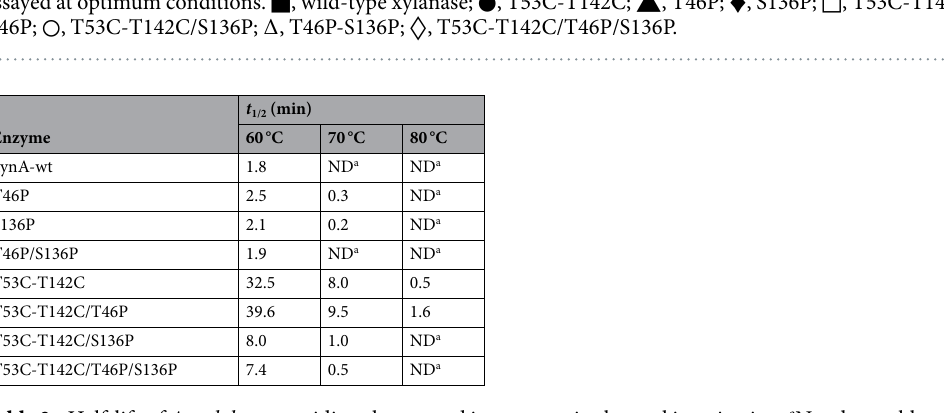
Table 3. Half-life of A. sulphureus acidic xylanase and its mutants in thermal inactivation. a Not detectable.